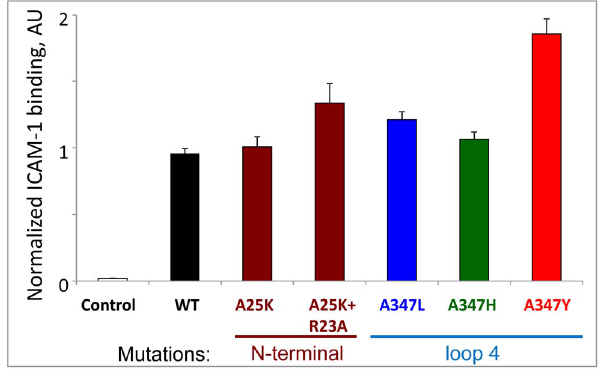
Figure 2. ICAM-1 binding by mutated DBL2 b constructs. Single or double mutations in N-terminal sub-domain or single mutations (A R L, H, Y) in Loop 4 do not reduce ICAM-1 binding activity. WT, wild type. AU, arbitrary units. Error bars represent Standard Deviations. Control, HisAdEx negative control construct.